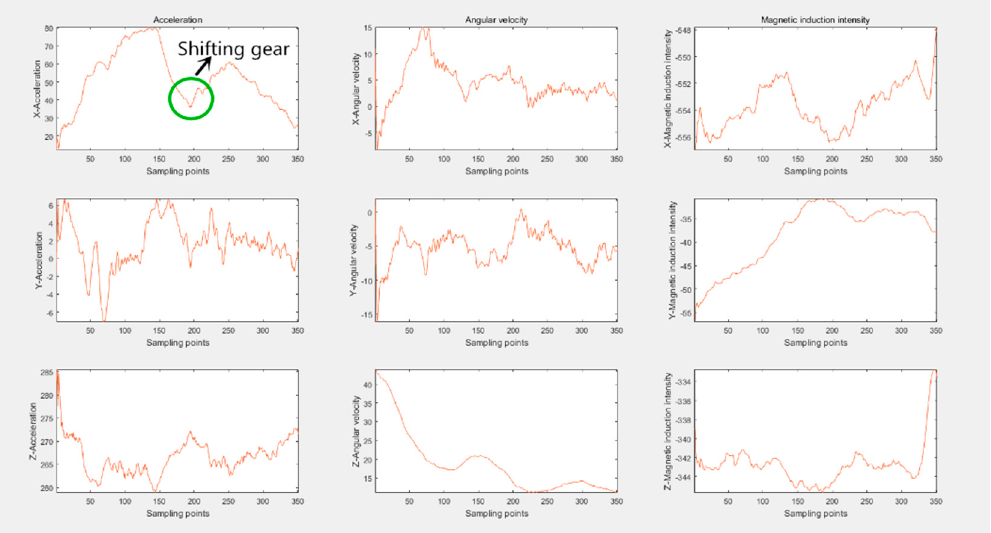
Figure 6. The actual 9-axis data portraying ACC.